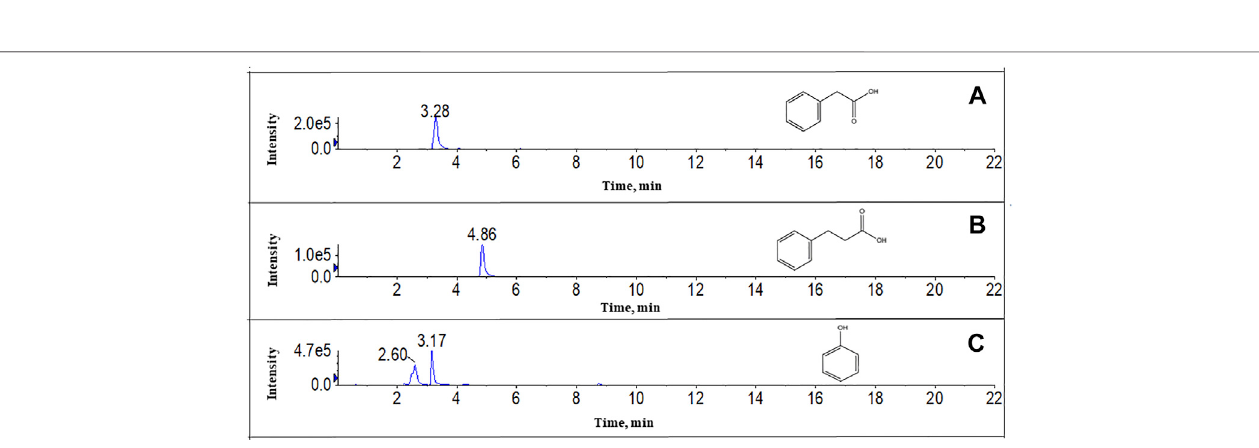
FIGURE 8 | Extracted ion chromatogram (XIC) of the two transitions to (A) phenylacetic acid, (B) phenylpropanoic acid, and (C) phenol in the collected sample 2 (treated ef fl uent) by LC-MS/MS-SRM.